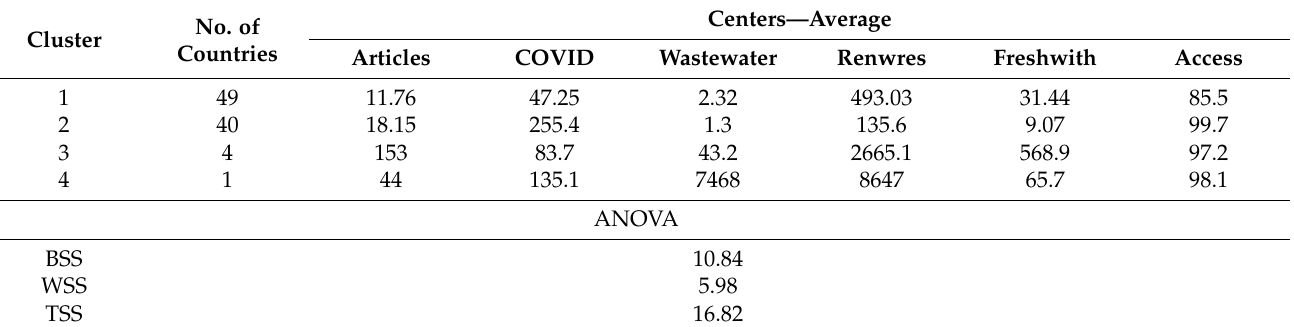
Table 6. Robust regression results.